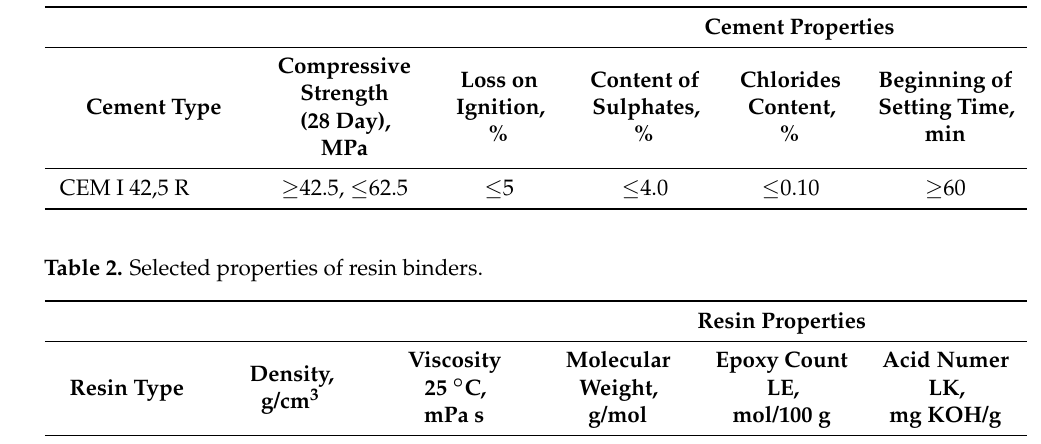
Table 1. Selected properties of cement.